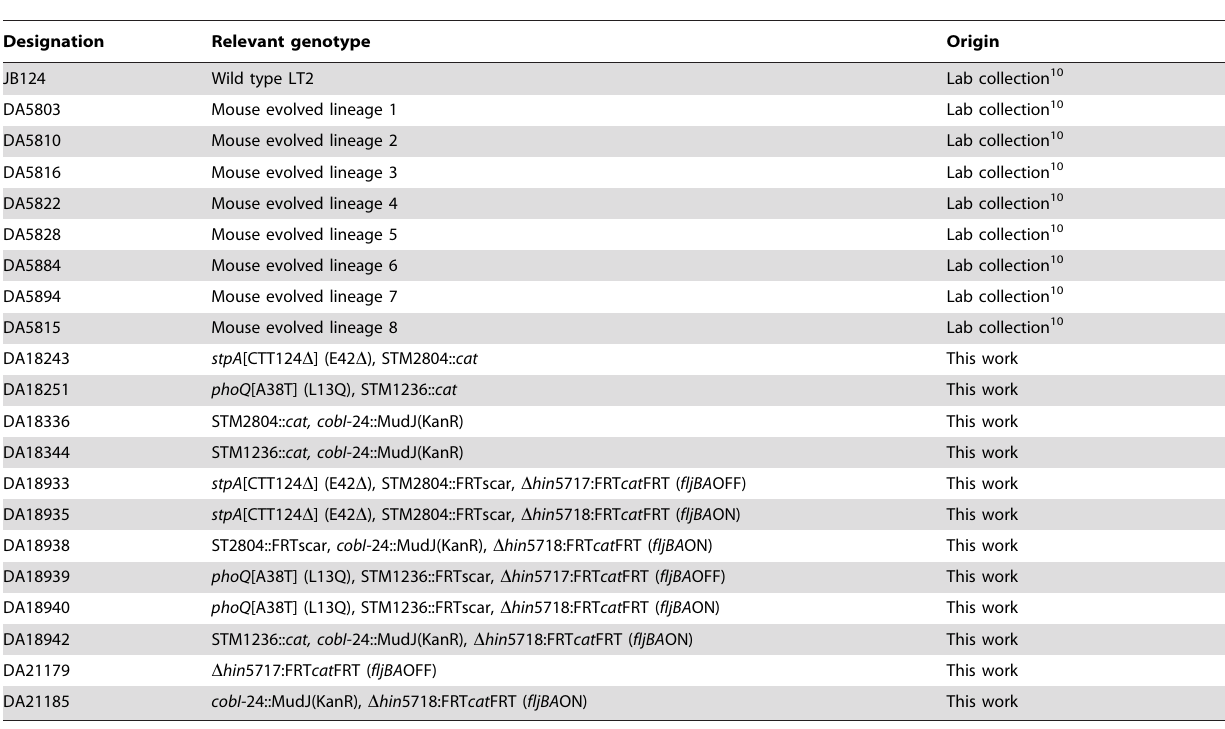
Table 1. Strains of S. typhimurium used in this